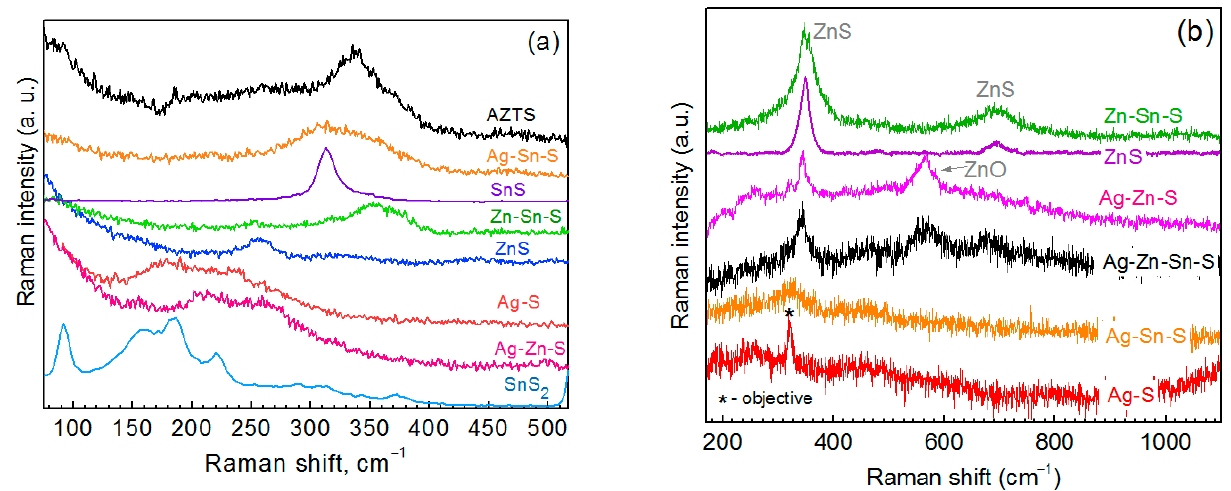
Figure 7. Raman spectra of the typical AZTS NCs and NCs of all possible binary and ternary compounds at λ exc = 532 nm ( a ) and λ exc = 325 nm ( b ).